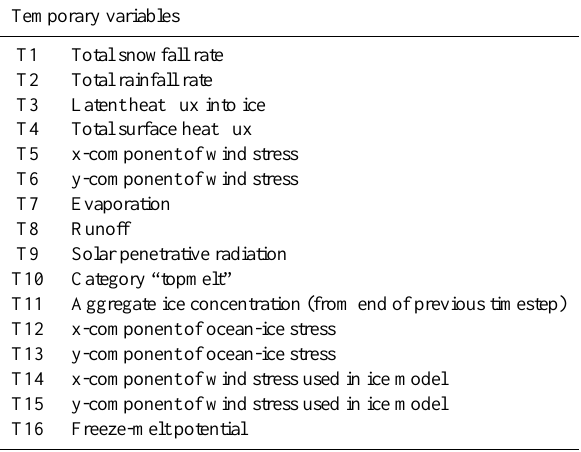
Table 1g. Table of temporary variables as used in the coupling op- erations described in Tables 1a, d and